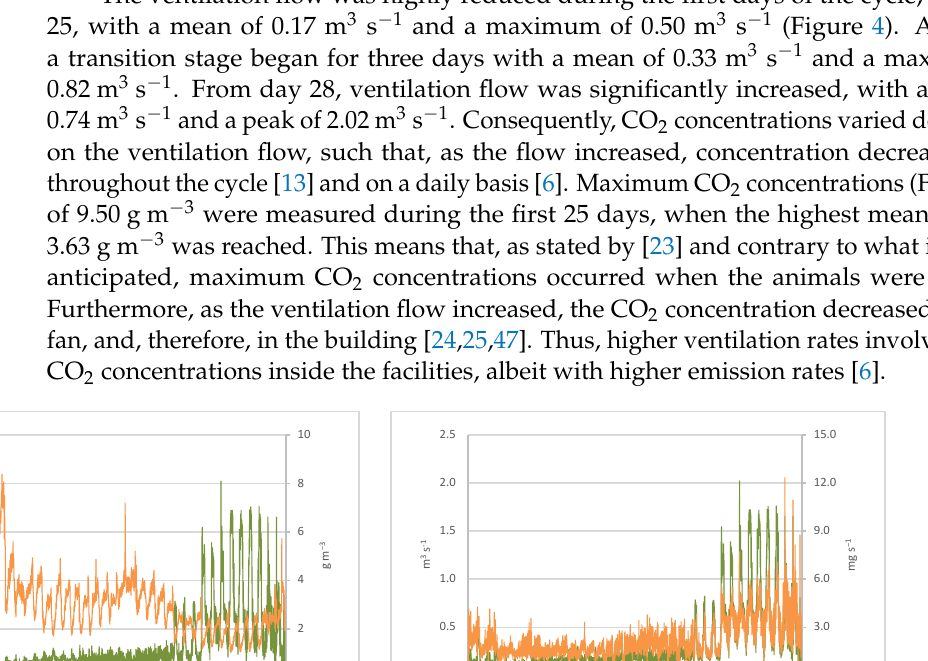
( B ) Figure 5. Correlation between ( A ) CO 2 concentration, C CO2 (g m − 3 ), – potential approximation, and ( B ) CO 2 emission per animal, E CO2 (mg s − 1 ), – linear relationship, and ventilation flow, Q (m 3 s − 1 ) ◦ measured values throughout the cycle 3.4. Neural Networks for the Prediction of CO 2 Emissions Table 5 shows the mean performance of the 10 min and 60 min prediction models after 40 iterations.